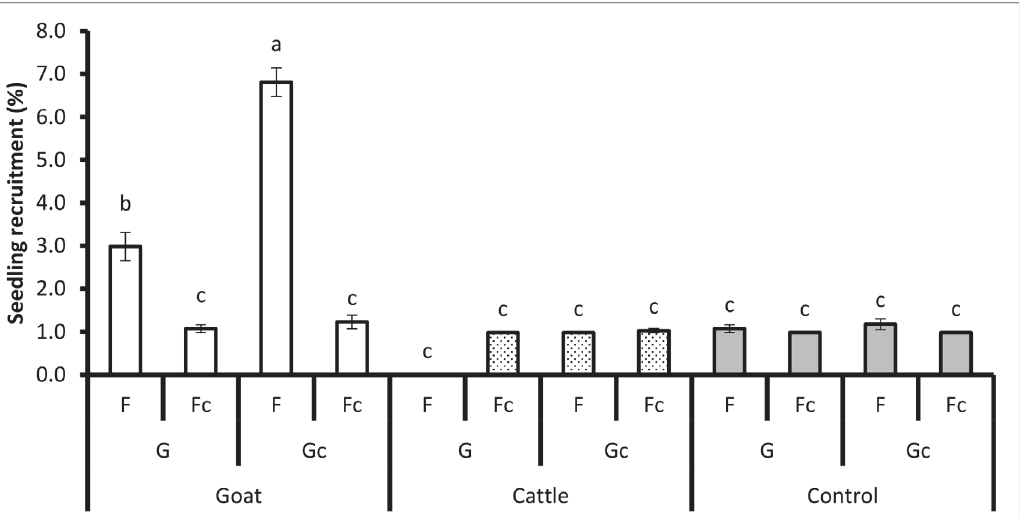
Fig 2. The treatment combination effects of animal species (goats, cattle), unpassed/untreated seeds (i.e. not ingested), grass (G) (and mowed grass (Gc)), fire (F) (and no fire (Fc)) on seedling recruitment during the dry season. Bars represent standard errors (S.E.). Same letters on the bars mean that P > 0.05. A LSD post hoc test was